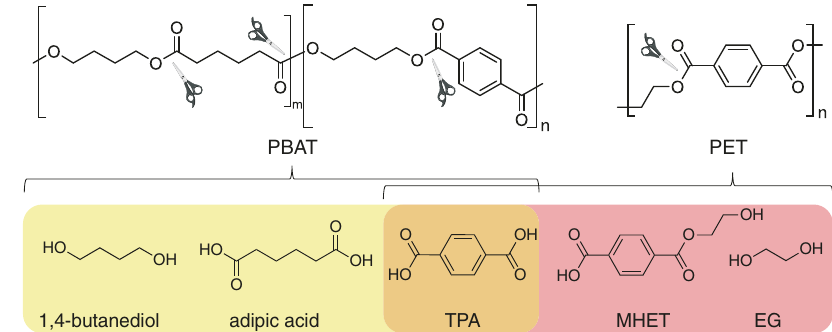
Fig. 1 | Chemical structures of PBAT and PET and the putative ester hydrolysis products. Similar to PET, biodegradation of PBAT could also yield